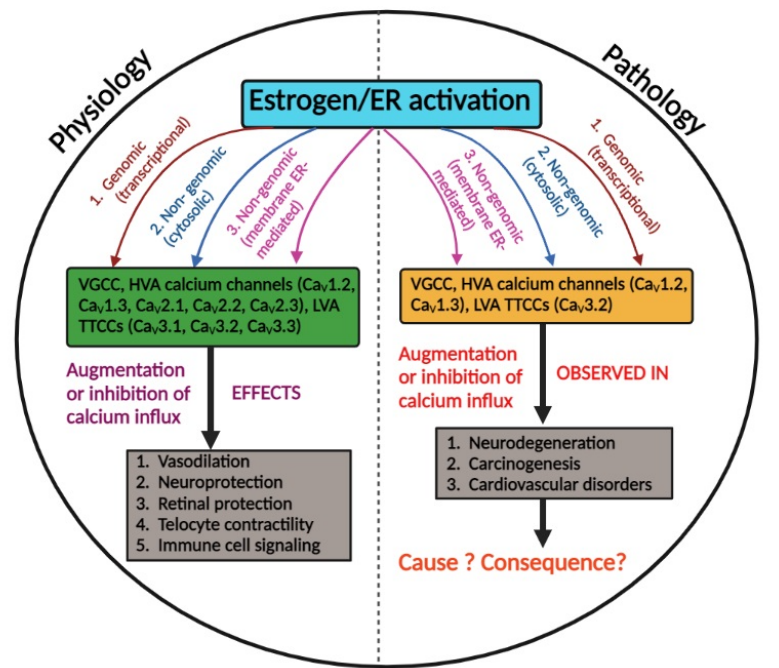
Figure 1. Overview of estrogenic modulation of VGCCs in physiology and pathology. Left: in physiological conditions, estrogen/ER activation modulates the calcium influx via VGCCs which contributes to various physiological functions. Right: estrogen/ER activation modulates the calcium influx via VGCCs which is observed in various disease conditions. However, whether this modulation causes the pathology or is merely a consequence requires further investigation. Table 4. Models/tools to study ligand-voltage-gated ion channel interaction.